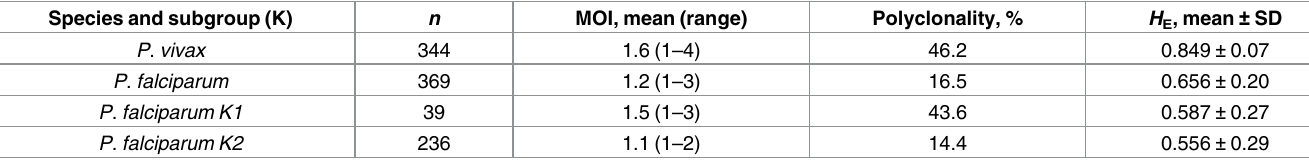
Table 2. Within-host and population diversity. Species and subgroup (K) n MOI, mean